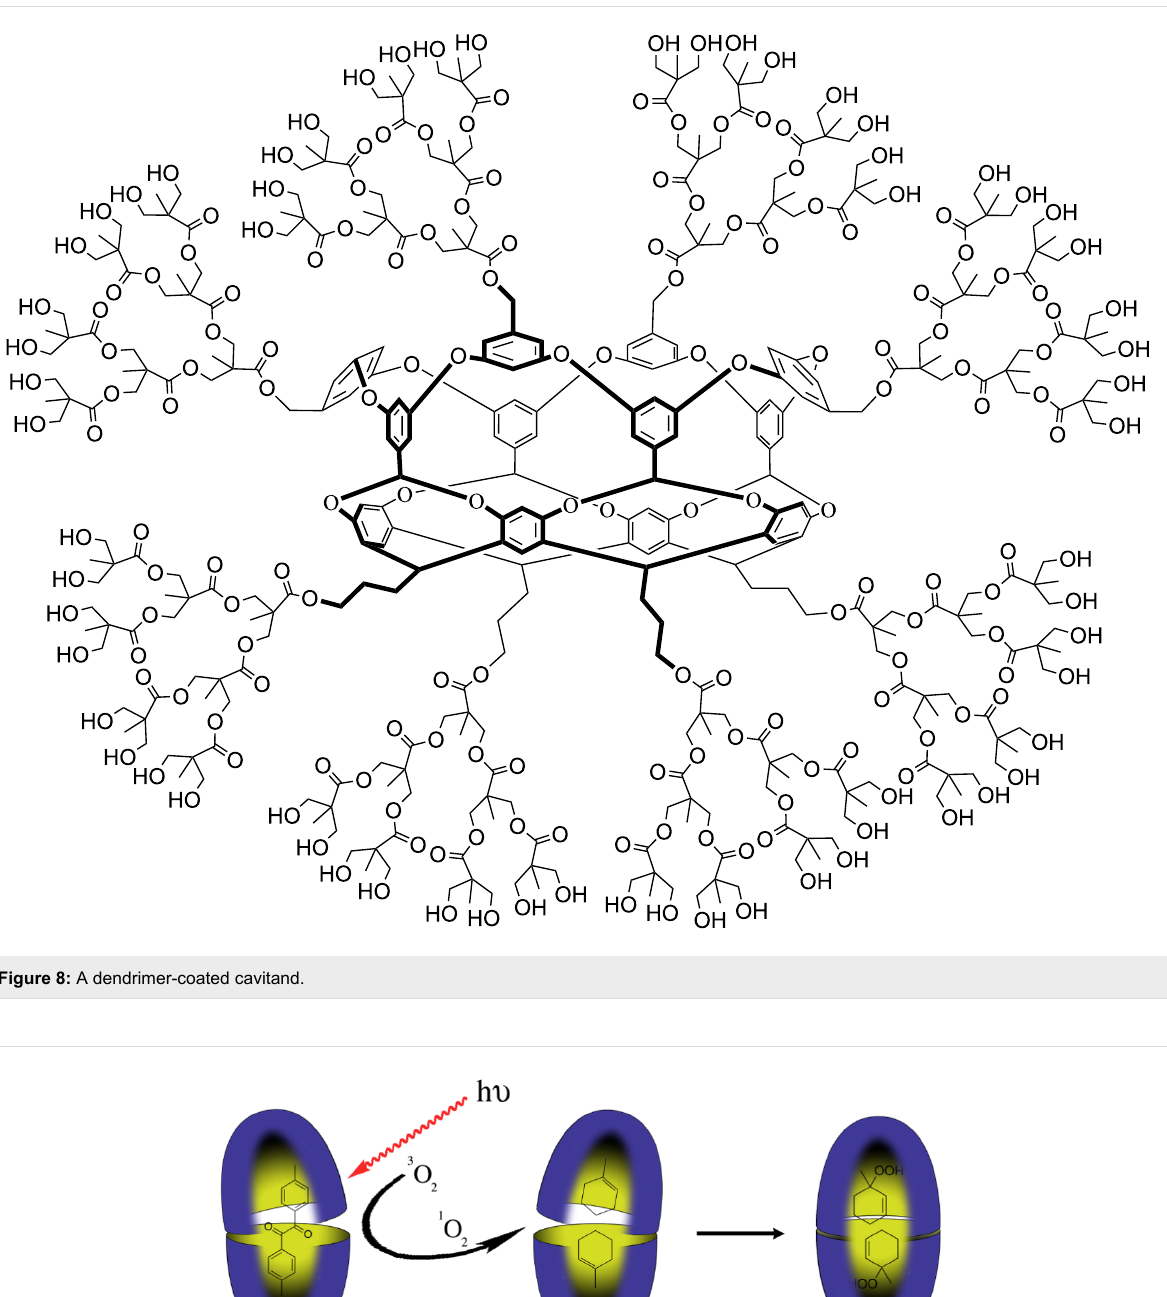
Figure 9: Selective oxidation of olefins by singlet oxygen.